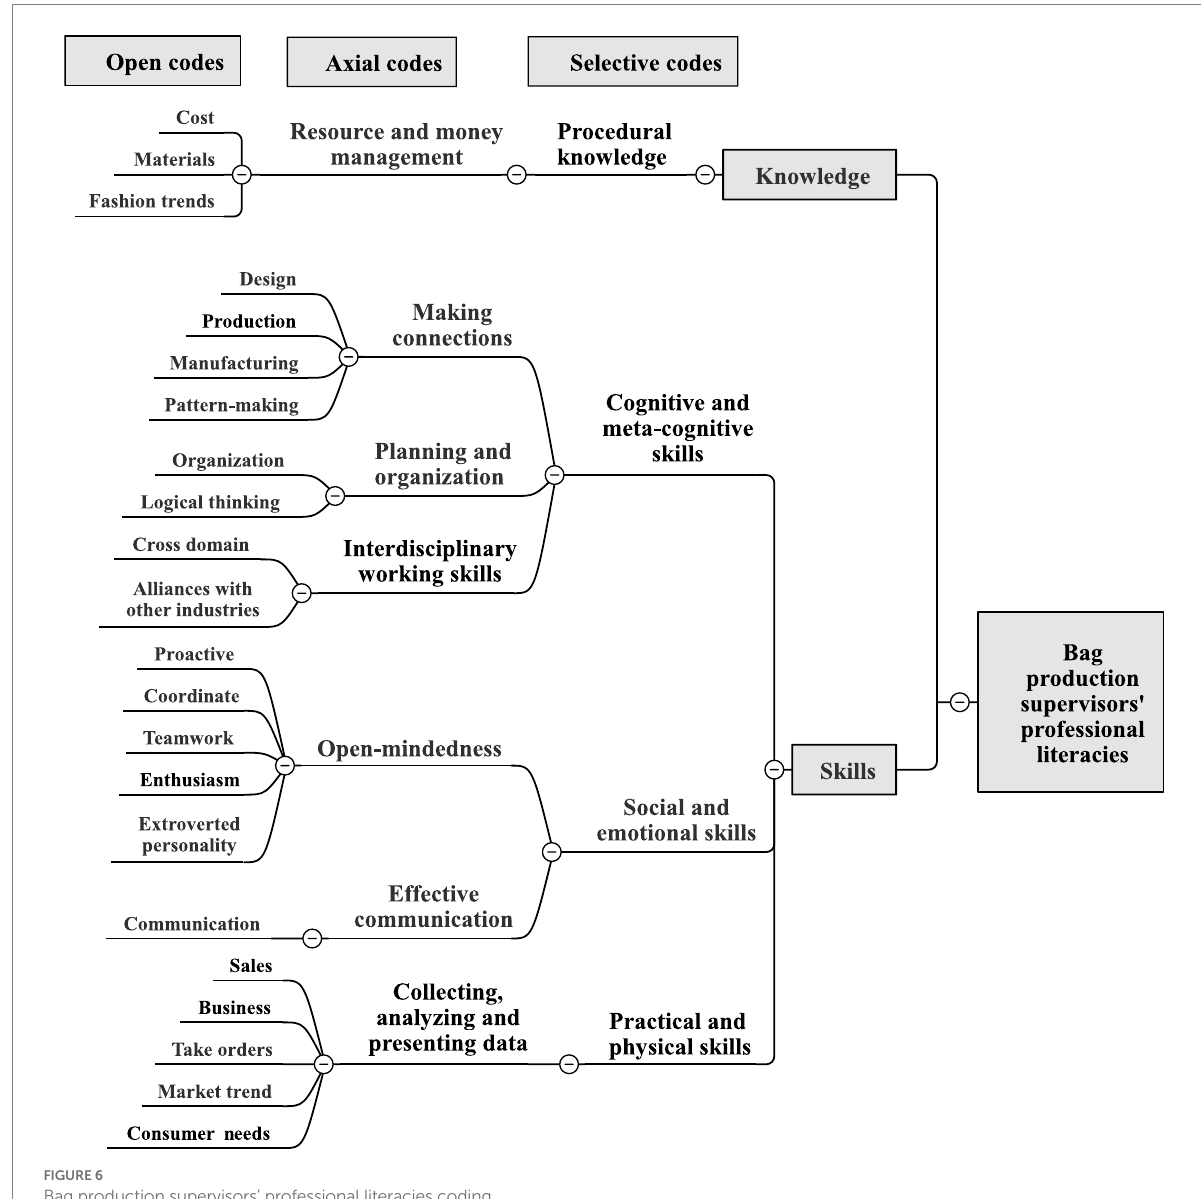
FIGURE 6 Bag production supervisors’ professional literacies